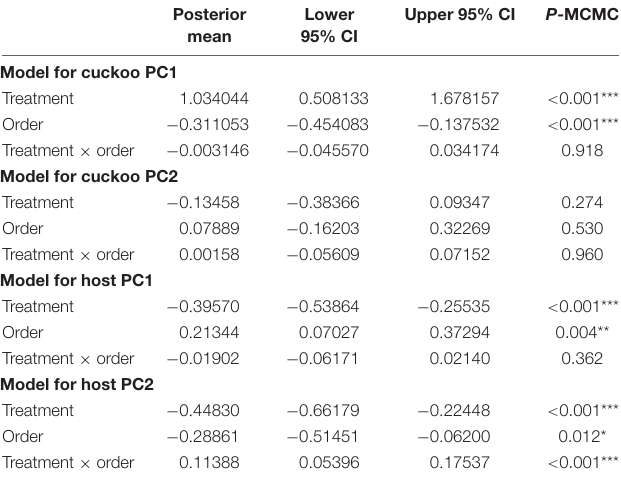
TABLE 2 | The responses of common cuckoo (Cuckoo) and oriental reed warbler (host) nestlings in different experimental treatments by generalized linear mixed model.